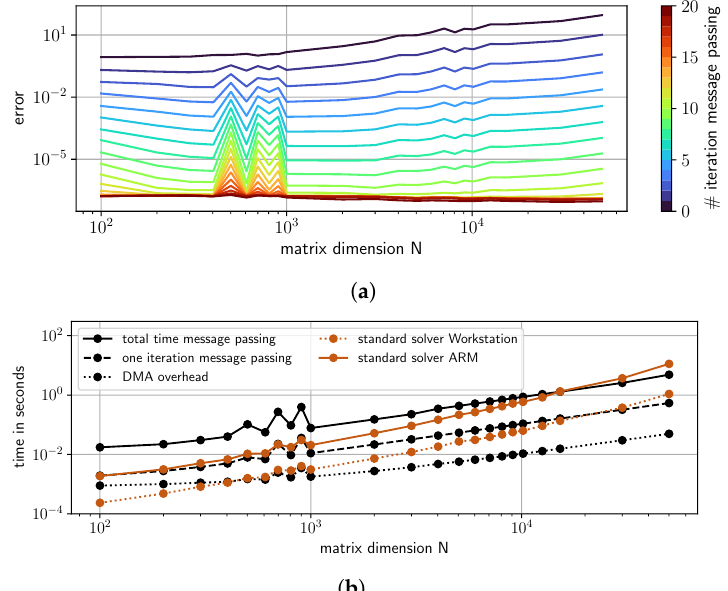
Figure 12. The plots show the performance of our approach when solving the FEM LESs on the Zynq UltraScale board. In ( a ), the error of our approximated solution after a certain number of Message Passing iterations is shown. In ( b ), the times of the standard solver (running on the ARM processing system and the workstation) are compared to the total time our Message Passing Algorithm requires to archive a solution better than 10 − 5 . In addition, the time of a single iteration is plotted as well as the DMA